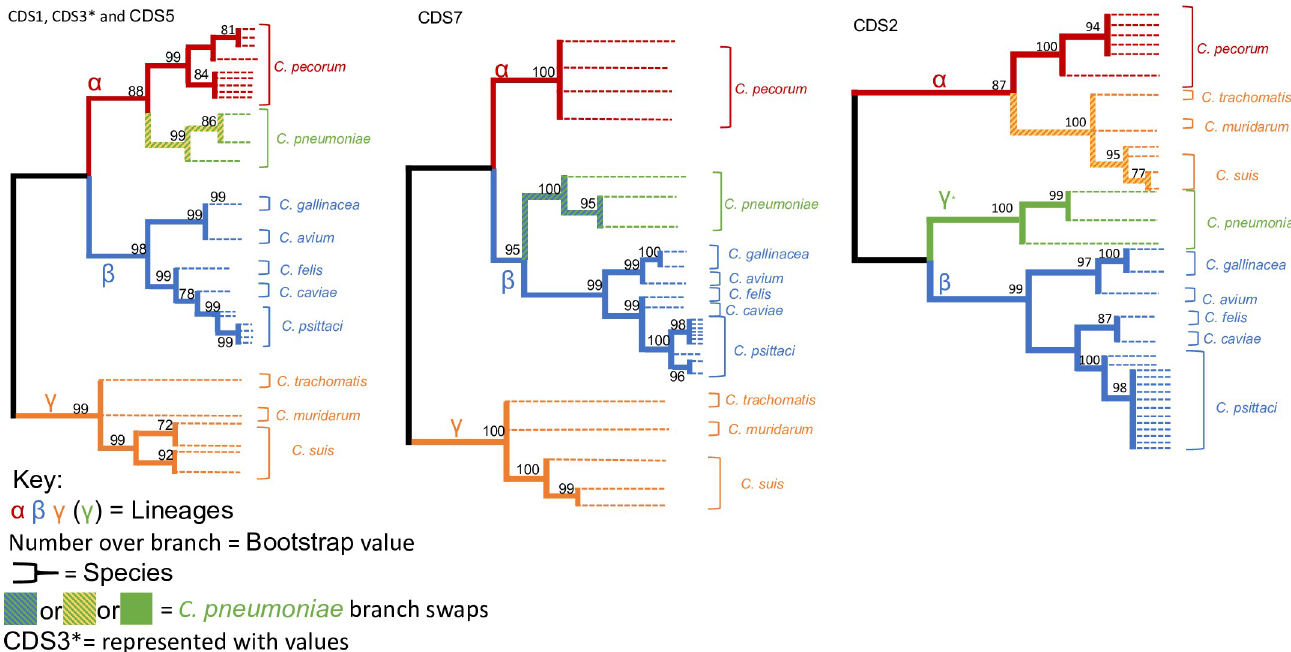
Fig 4. The Maximum Likelihood estimate for gene group A with the following five coding sequences being present; CDS1, CDS2, CDS3, CDS5, and CDS7.